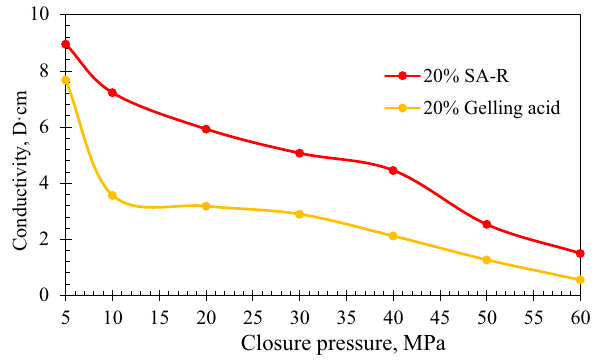
Fig. 9 Conductivity of two acid liquids under different closure pres-